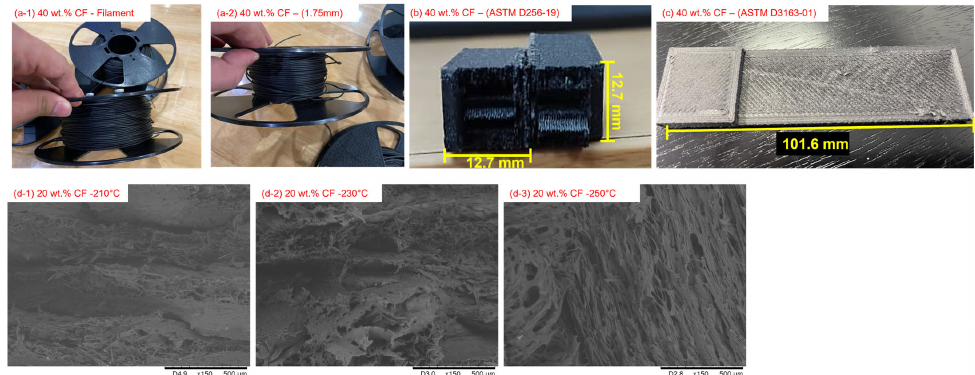
Figure 1. ( a ) Images of the 40 wt.% fi lament with a 1.75 mm diameter fabricated using the 3Devo fi lament maker; ( b ) 40 wt.% impact test samples after breakage (cross-section view); ( c ) one-sided shear test sample with a composition of 40 wt.% CF; and micrograph images of printed 20 wt.% samples at several temperatures: ( d-1 ) 210 °C, ( d-2 ) 230 °C and ( d-3 ) 250